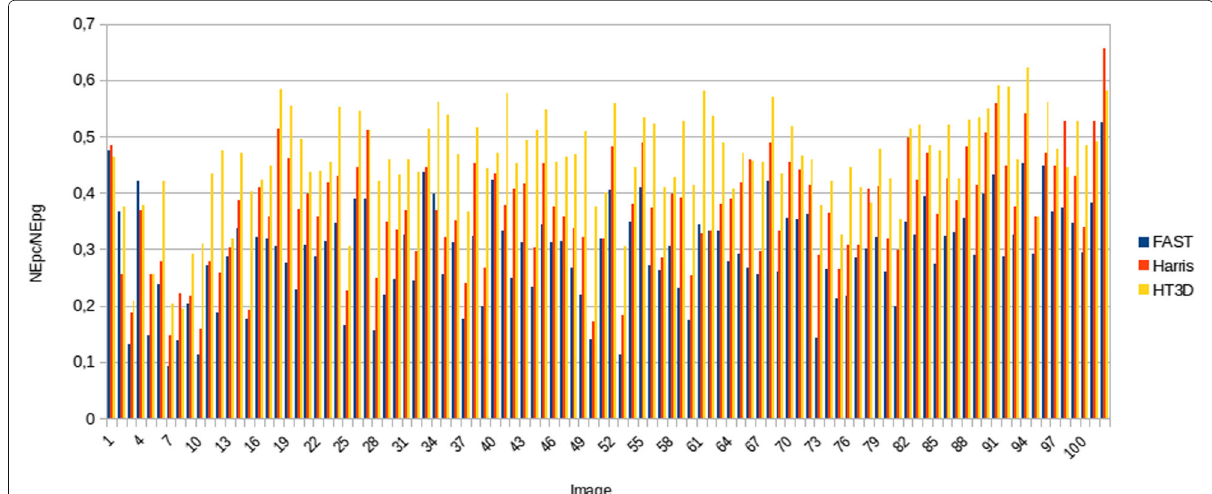
Fig. 19 Ratio between NEp c (number of correct matchings between ground truth and detected points) and NEp g (number of ground truth points) for the whole dataset considering d Ep = 2 (distance between ground truth and detected points). The hit rates of the proposed method remain higher than the hit rates of the other two methods when reducing d Ep . No significant differences in the accuracy of the three methods can be appreciated in comparison to greater values of d